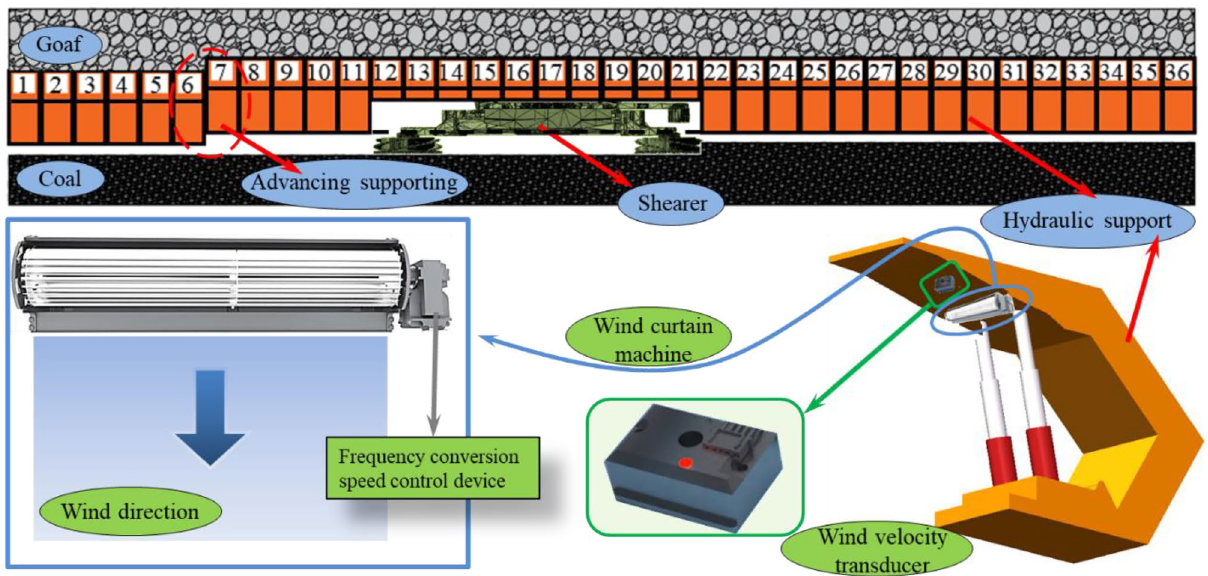
Figure 9. Air curtain tracking closed dust control system equipment